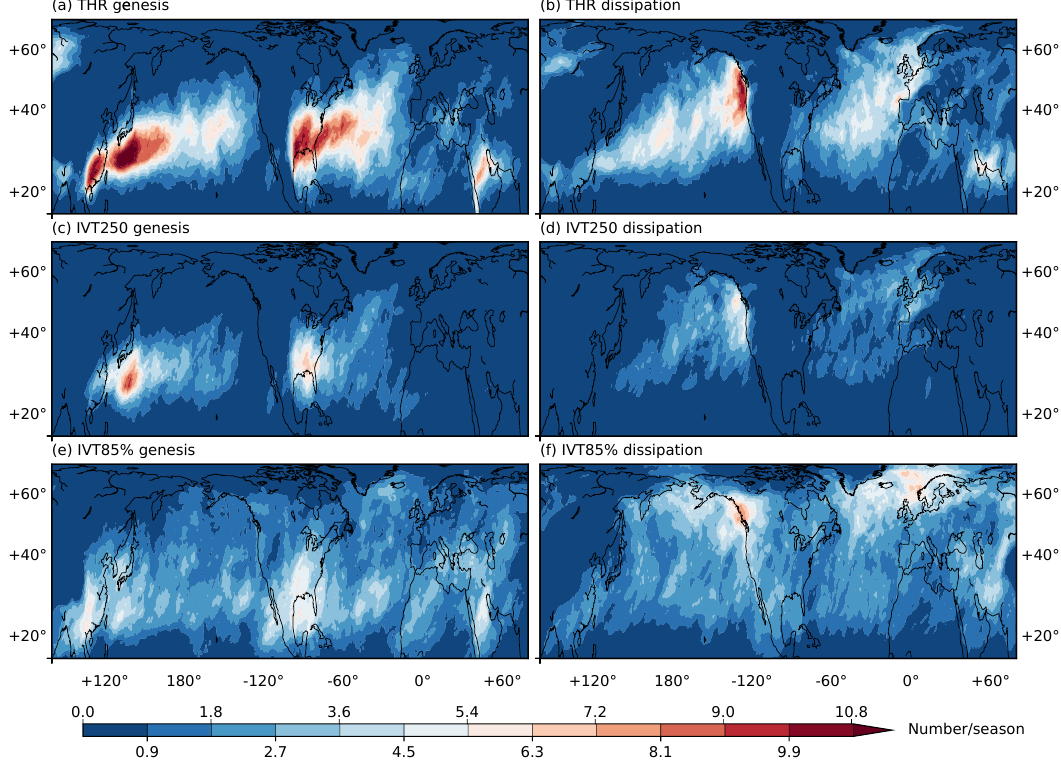
Figure 4. Distribution of genesis ( a , c , e ) and dissipation ( b , d , f ) occurrences of AR tracks found by THR method ( a , b ), IVT250ano ( c , d ) and IVT85% ( e , f ) method. Only tracks longer than 24 h are